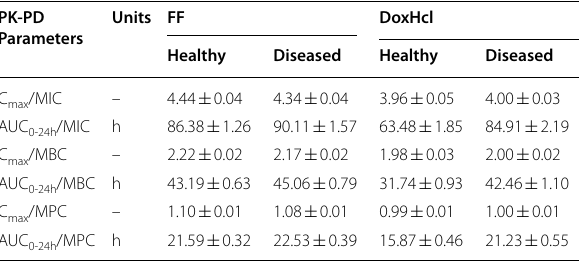
Table 3 The PK-PD parameters for DoxHcl&FF against APP